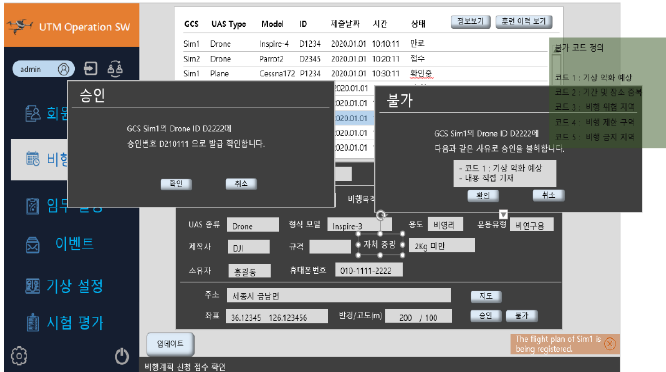
Figure 4. UOS (UTM Operating System) UI—registration window of a flight plan.